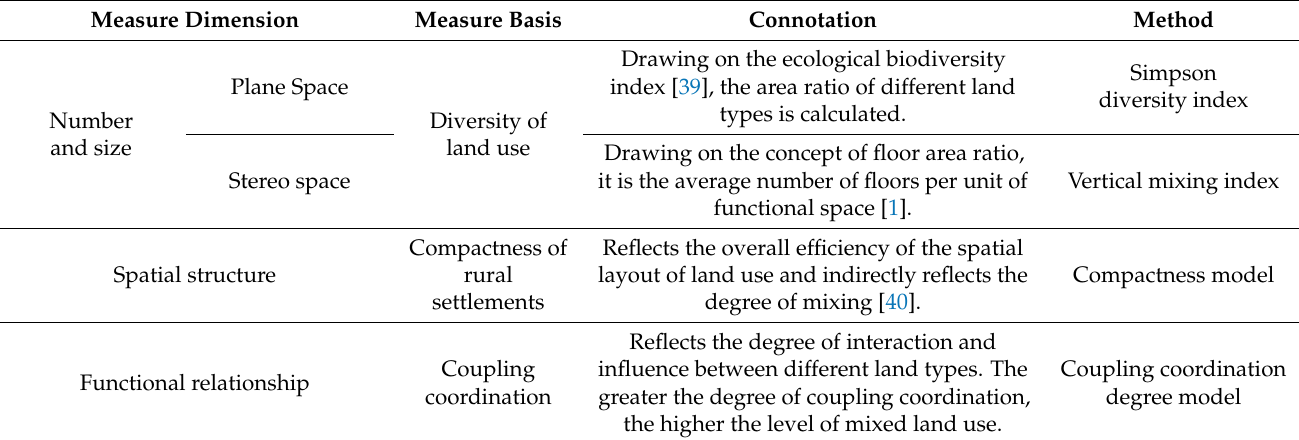
Table 3. Measurement system of MLU in rural settlements.